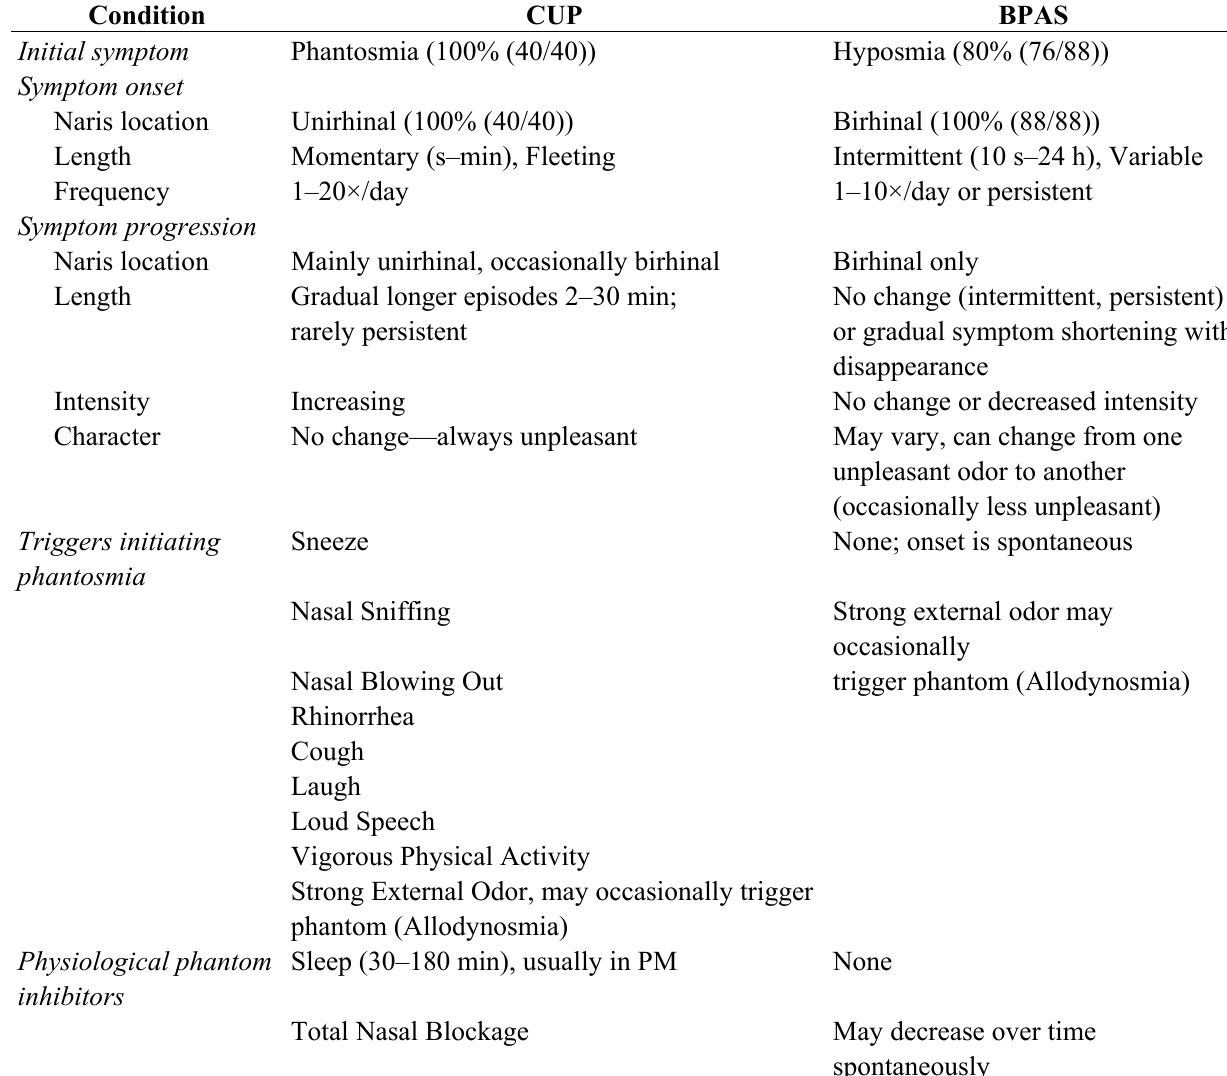
Table 3. Clinical history in patients with